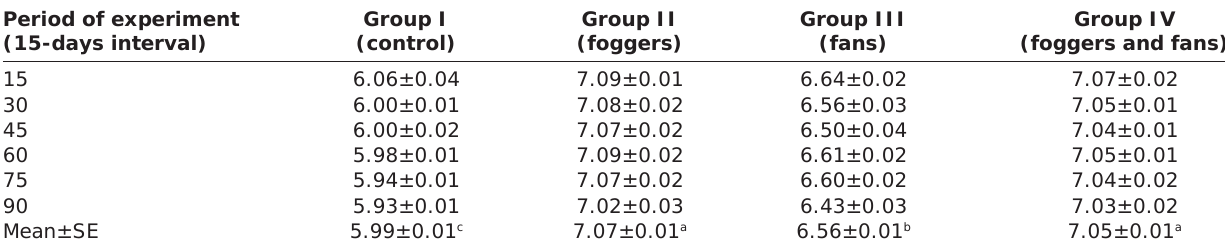
Table-10: Effect of microclimate alteration on milk fat (%) in Murrah buffaloes during summer. Period of experiment (15-days interval)